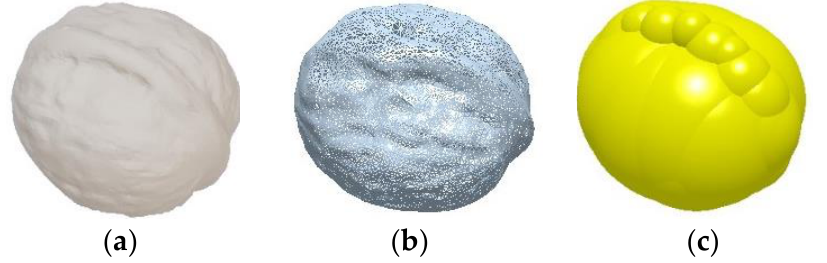
Figure 6. The construction process of the DEM simulation model of walnuts. ( a ) 3D scanning model of walnuts; ( b ) Mesh model of walnuts; ( c ) Simulation model of walnuts.